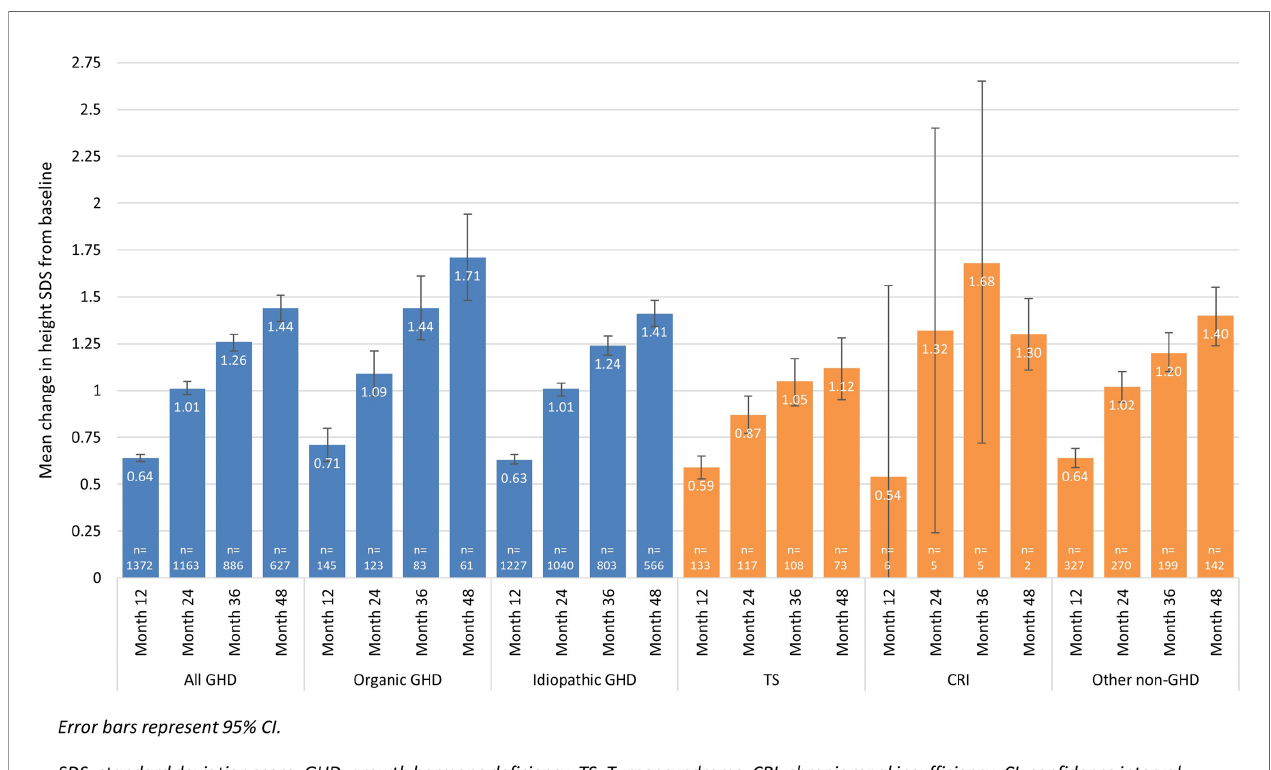
FIGURE 3 | Change in height SDS from baseline in treatment-naïve patients over 48 months, according to disease aetiology – Registry population